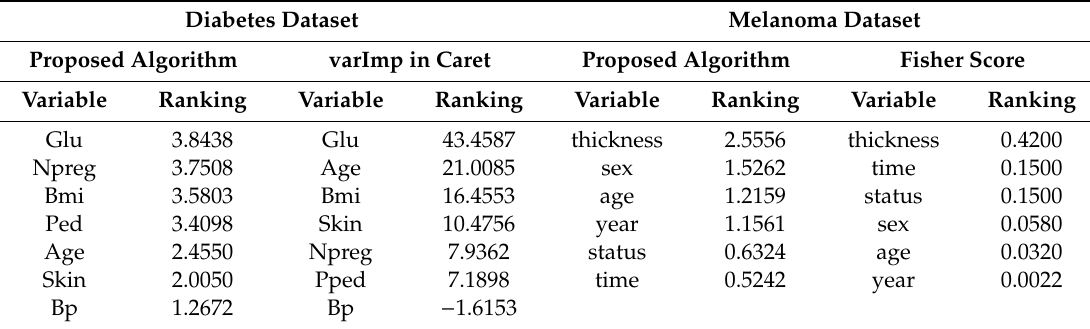
Table 3. Variable ranking results of Diabetes and Melanoma datasets.